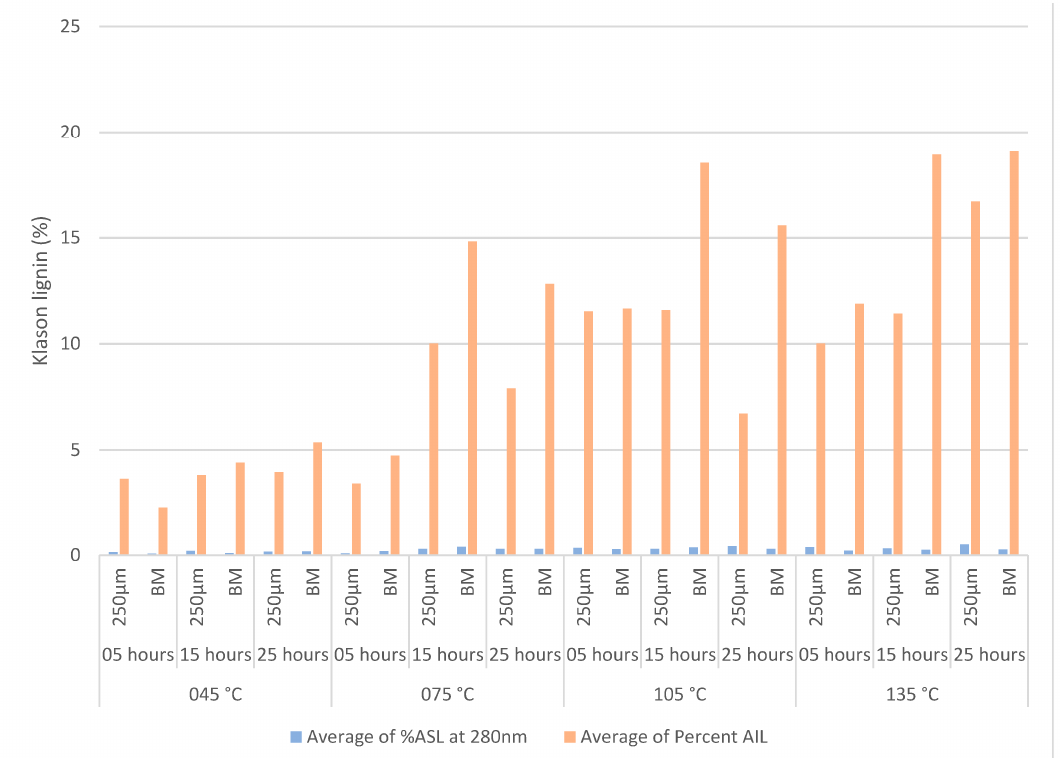
Figure 5. Klason lignin for stem samples after pretreatment.